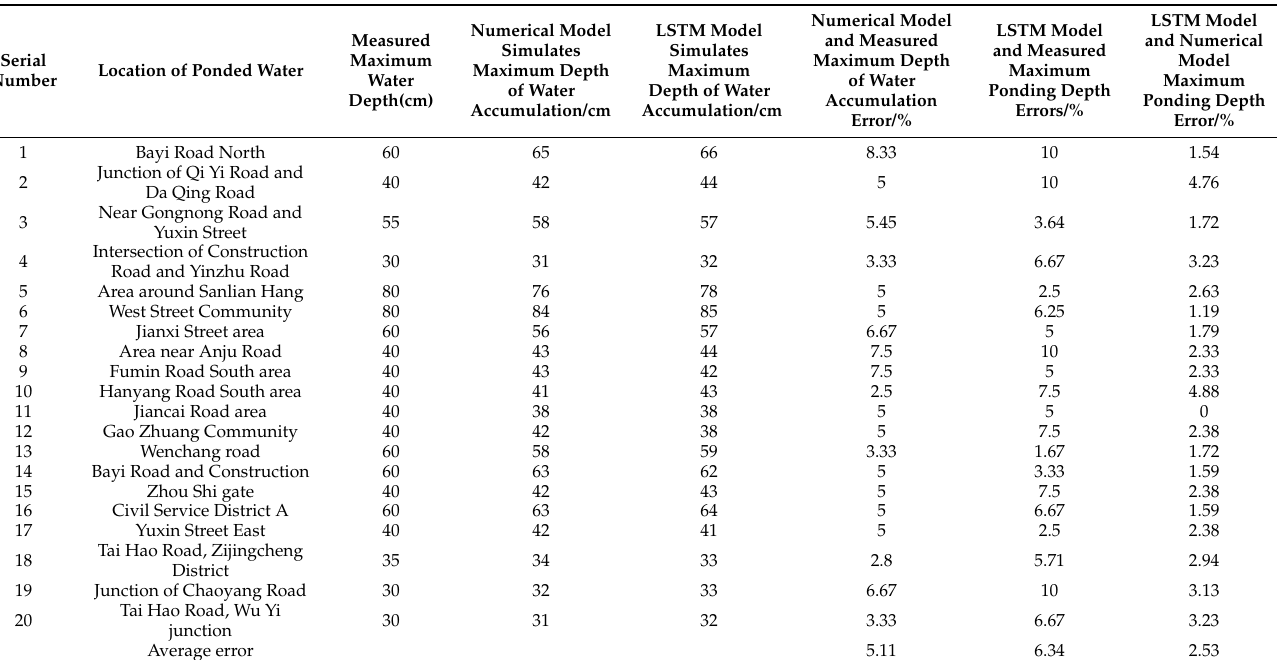
Table 2. 2021.7.20 Comparison of measured and simulated water depths at inundated water accumu- lation points.